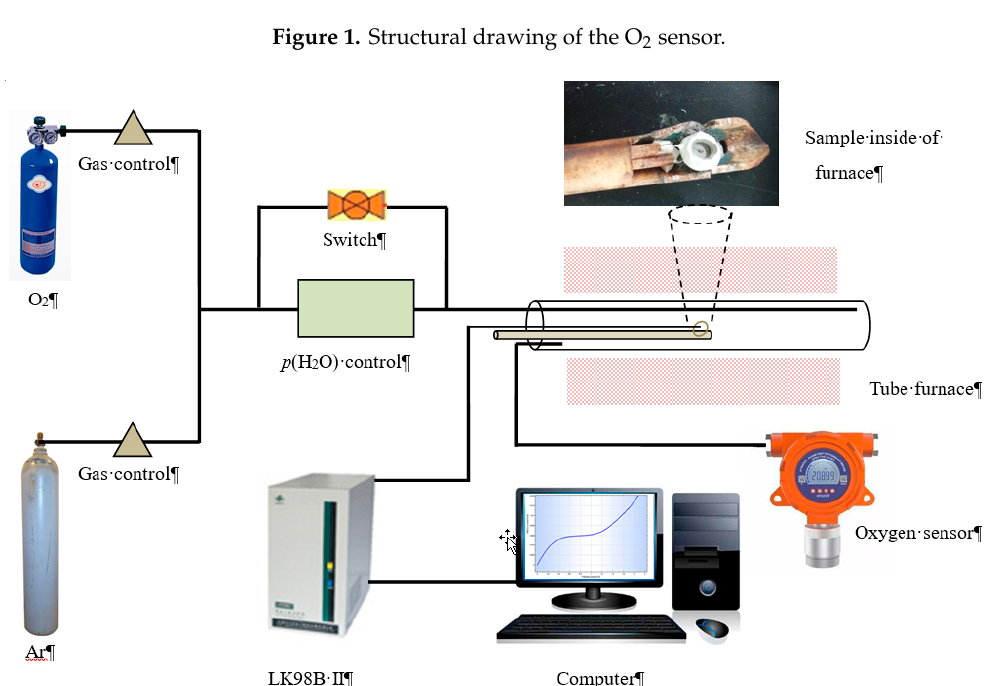
Figure 2. I - V characteristics testing system.